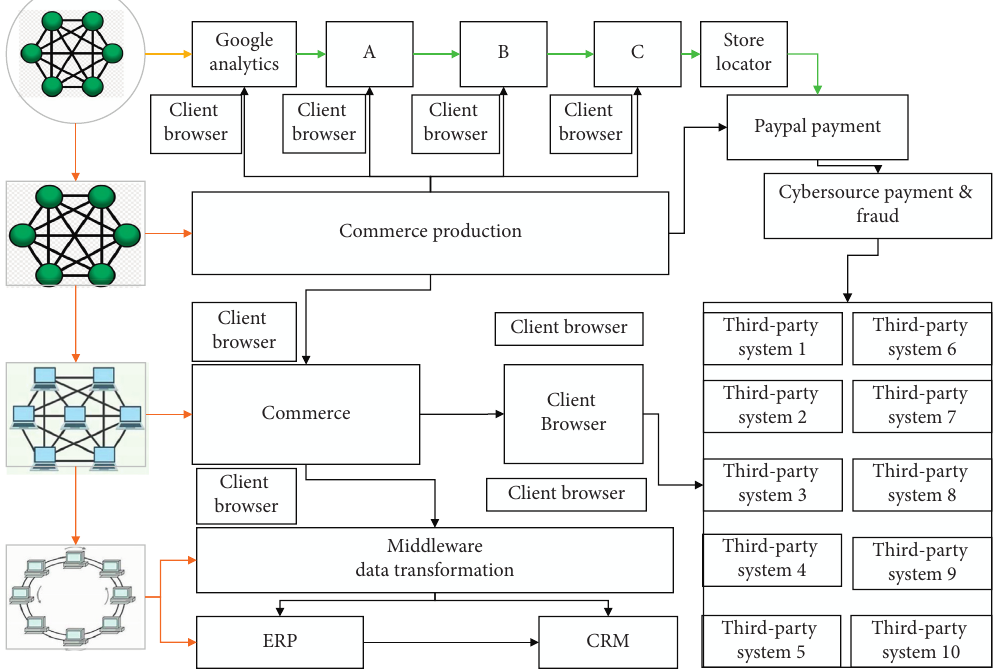
Figure 2: Interactive visual communication network topology optimization